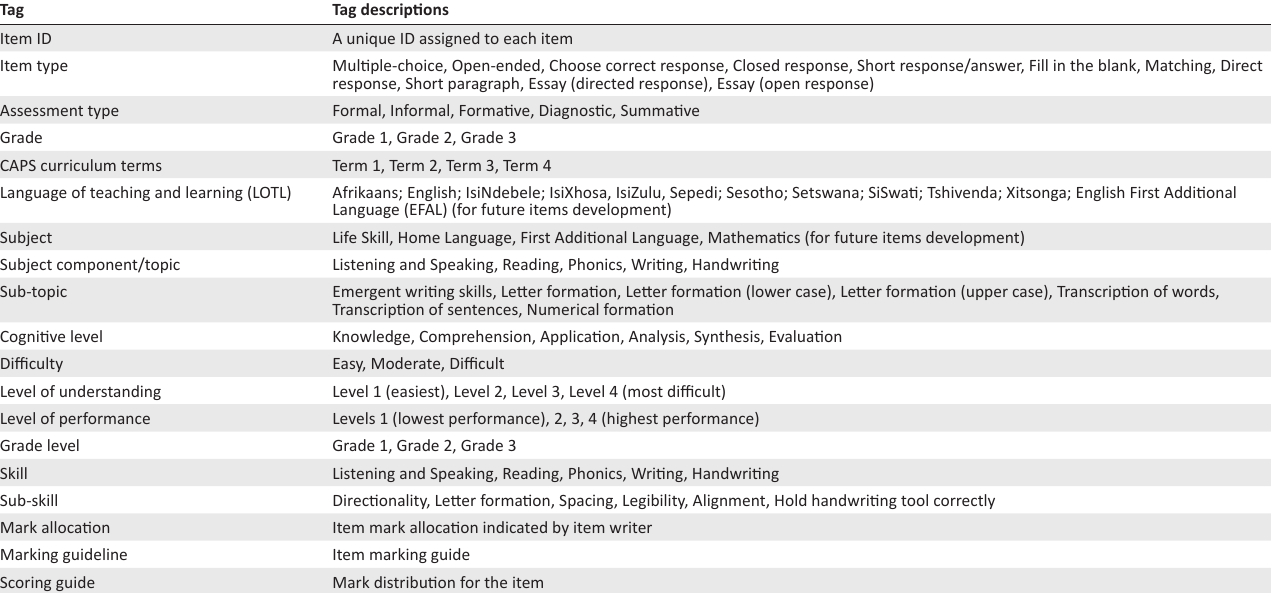
TABLE 1-A1: Foundation phase English home language tests and item pool